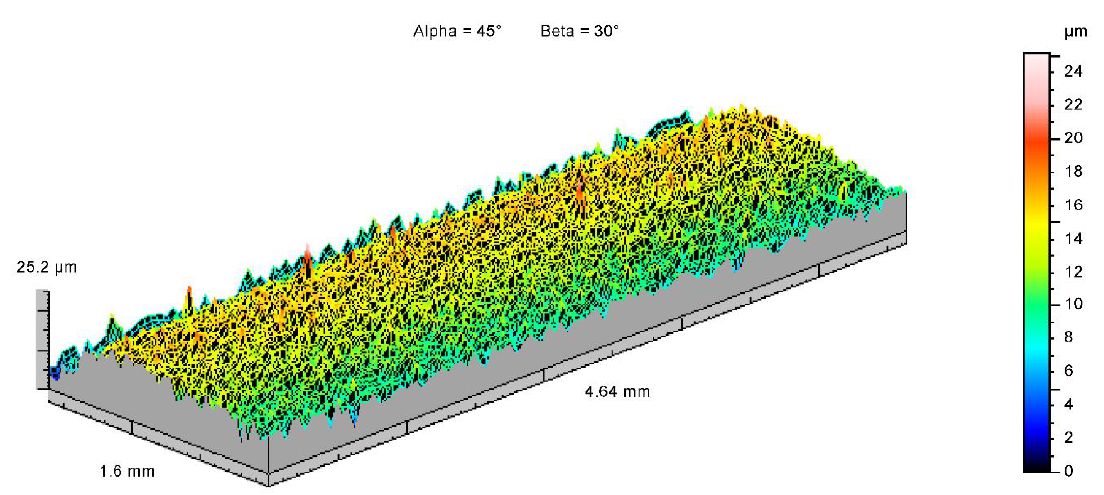
Figure 21. Stereometric surface image before machining.